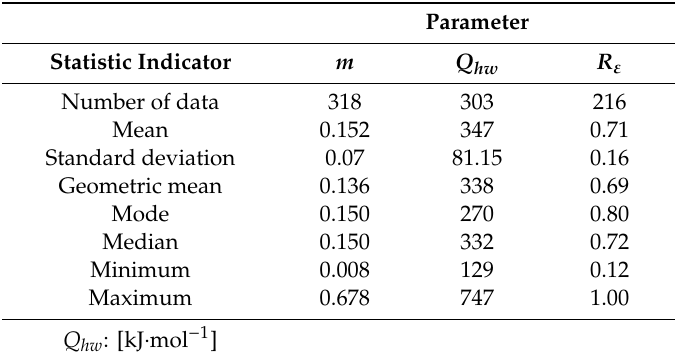
Table 1. Statistic indicators of the reviewed